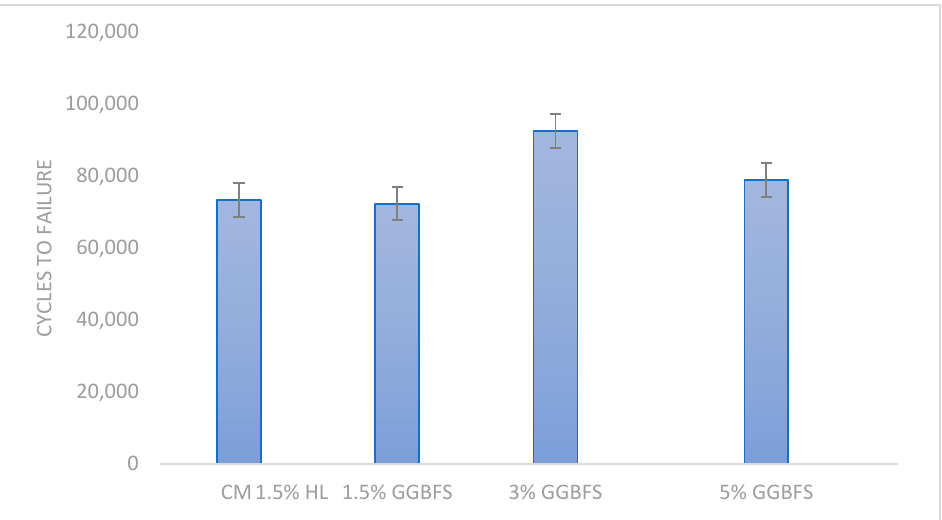
Figure 5. Fatigue life of different asphalt mixtures.